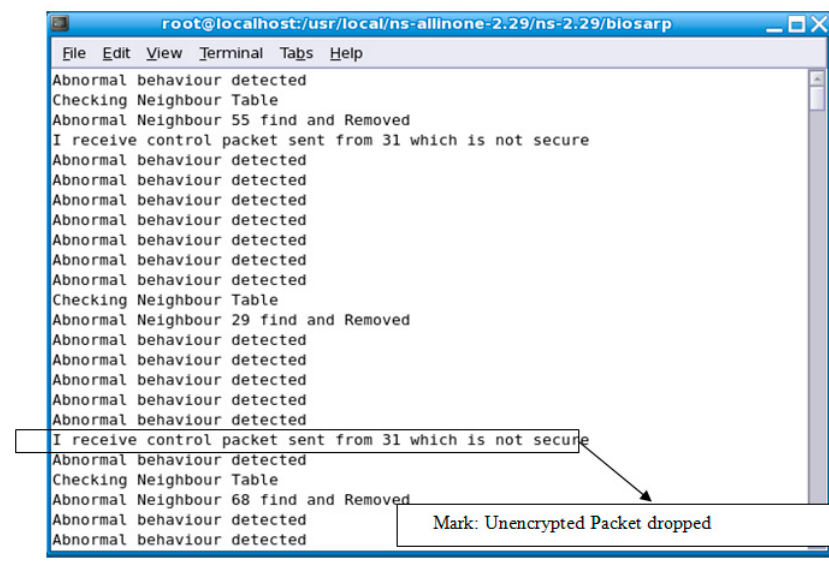
Figure 6. The output of actions taken by E-BIOSARP against adversaries.